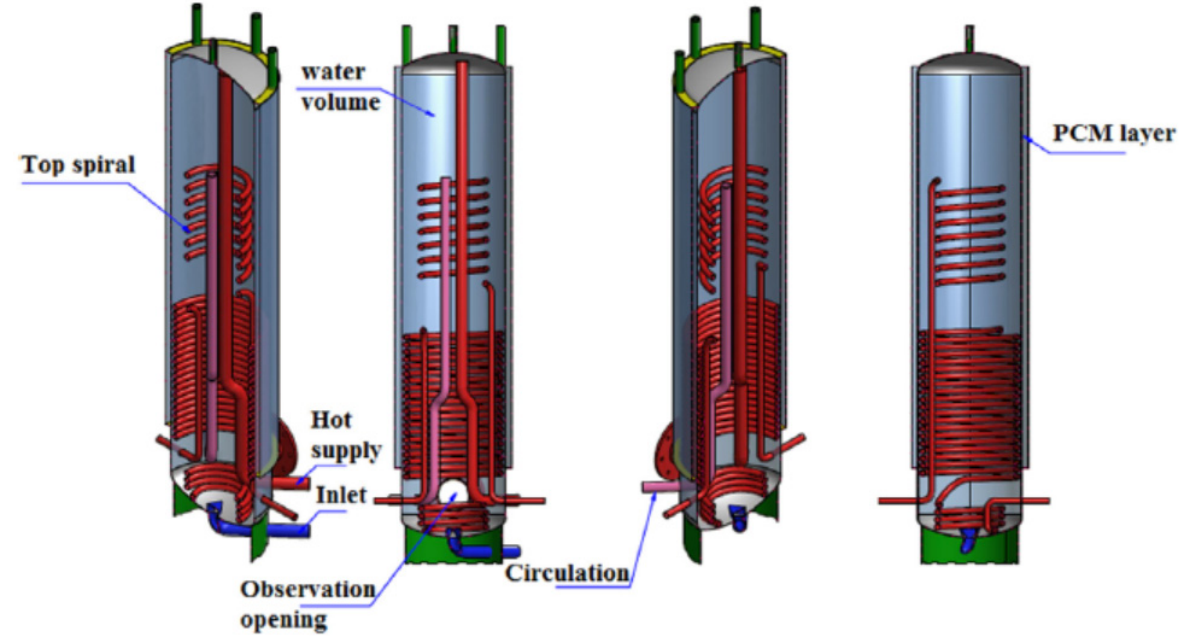
Figure 18. A design from Deng et al. with a PCM layer surrounding the water tank. Adapted with permission from ref. [137] 2018 Deng et al.